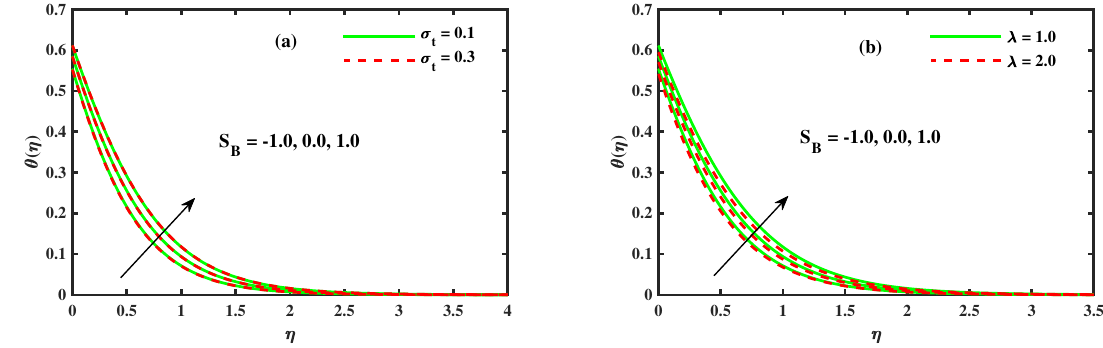
Figure 8. The impact of θ ( η ) for ( a ) unsteady parameter σ t and ( b ) thermal buoyancy λ . Figure 9a,b demonstrated the distribution of the temperature of distinct values of the Brownian motion parameter Nb , thermophoresis parameter Nt and with the suc- tion/blowing parameter S B . The impact of the Brownian motion parameter has been displayed in Figure 9a. Basically, Brownian motion supports heating the fluid in the boundary layer and immediately reduces particle deposition away from the fluid on the surface. Therefore, as Nb rises, the temperature increases. Figure 9b summarizes the effect of changes in thermophoresis parameters Nt on the temperature profile. Figure 9b outlines the influence of the variation of the Nt on the temperature profile. As the thermophoresis parameter surges, the thickness of the thermal boundary layer grows as Nt increments. In reality, nanoparticles have moved from a hot surface to a cold ambient liquid, so the temperature of the boundary layer rises. This impacts the development of the thermal boundary layer thickness. Figure 10a,b present the behavior of the nanoparticles concentra- tion profile with different values of the thermophoresis parameter Nt , Brownian motion parameter Nb and Stefan blowing parameter S B . The impression of the thermophoresis parameter Nt on the concentration profile (see Figure 10a) is identical to that of the temper- ature profile θ ( η ) (see Figure 9b). The impact of Nb on the distribution of the concentration exists in Figure 10b. The concentration profile was diminished because of changes in the uneven development of the nanoparticles in the framework. This reinforces the thermal exhibition as vitality changes hugely, prompting a decrease in the layer